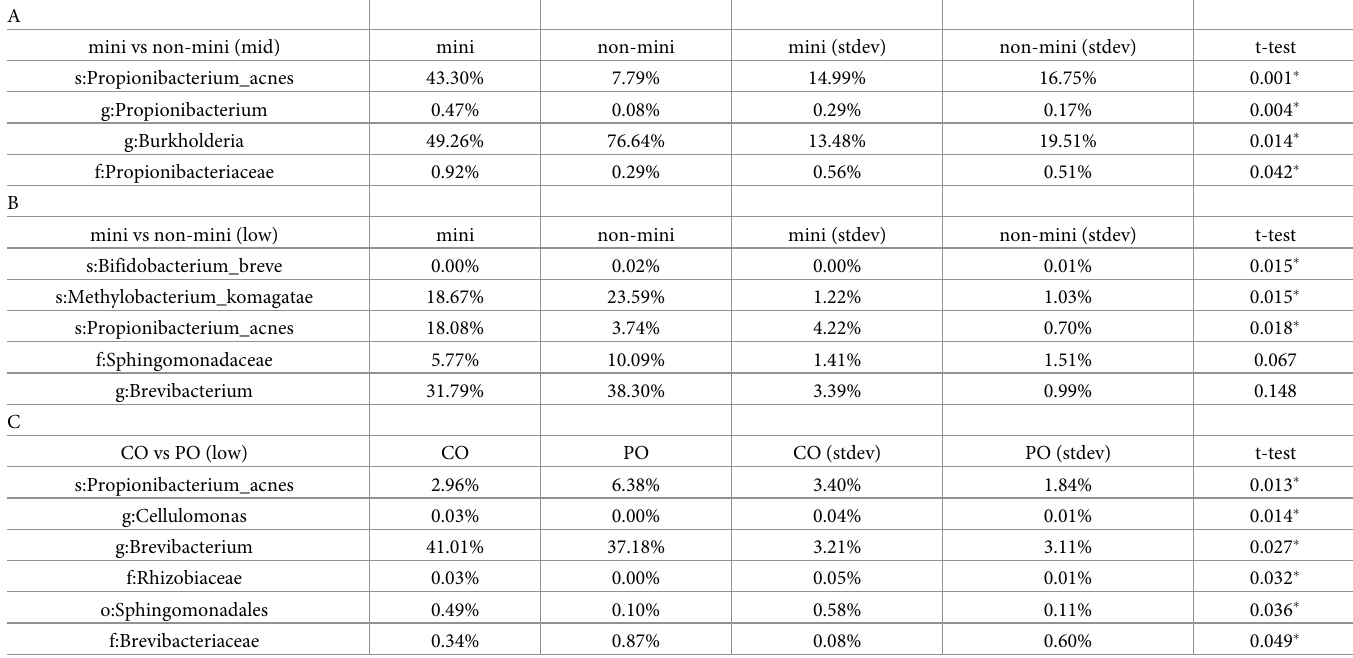
Table 3. Representative comparisons for bacteria abundance between middle portion hair samples.